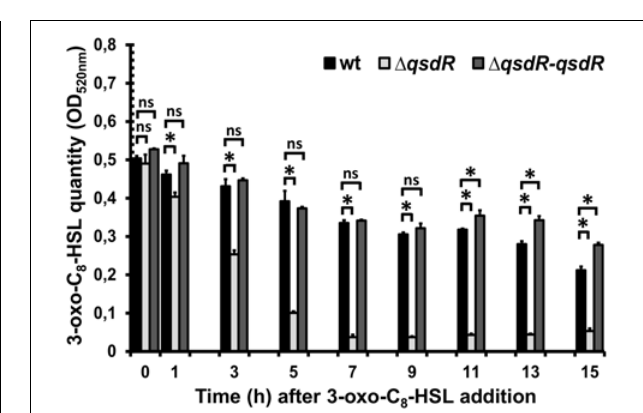
FIGURE 3 | Increased qsdA and qsdC mRNA levels in a (cid:49) qsdR mutant strain. qRT-PCR analysis shows the qsdA and qsdC mRNA levels in the (cid:49) qsdR mutant and in the complementing strain ( (cid:49) qsdR - qsdR ) grown in 7H9 medium at the mid-exponential (10 h) and stationary (19 h) phases. These mRNA levels are relative to the wild type strain. Data shown are mean values obtained from three independent experiments. Statistical analysis was performed by the DataAssist TM software (v3.01) used for calculating relative quantitation of gene expression, based on the comparative C T (2 − (cid:49)(cid:49) CT ) method. ∗ p -value < 0.05; ns means no significant difference.